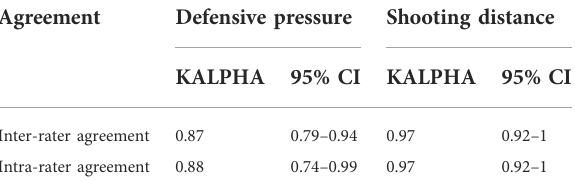
TABLE 2 Inter-rater and intra-rater agreement in defensive pressure and shooting distance.